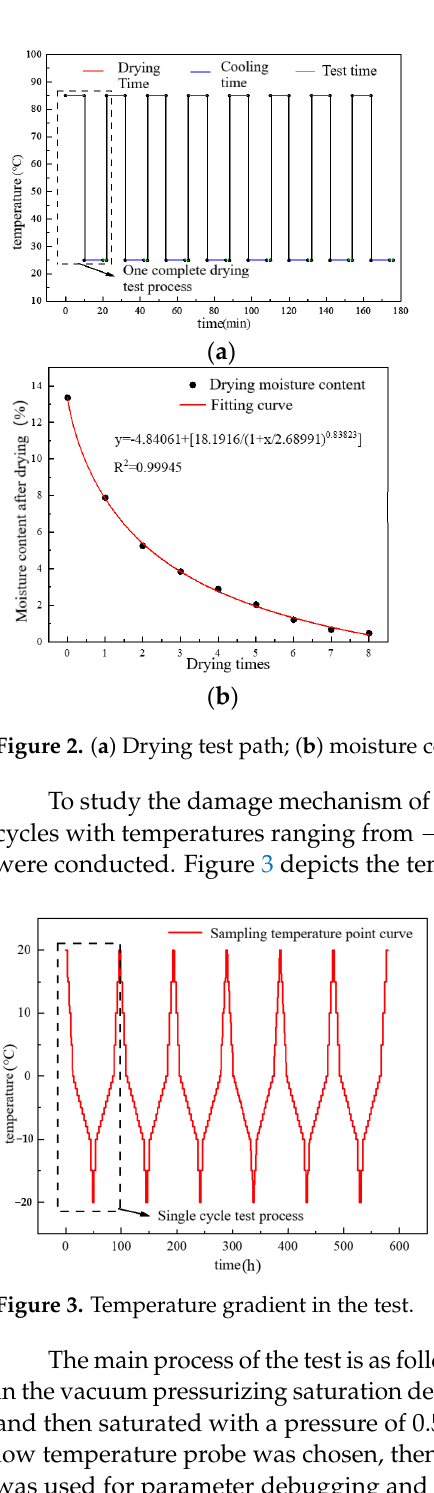
Figure 3. Temperature gradient in the test.